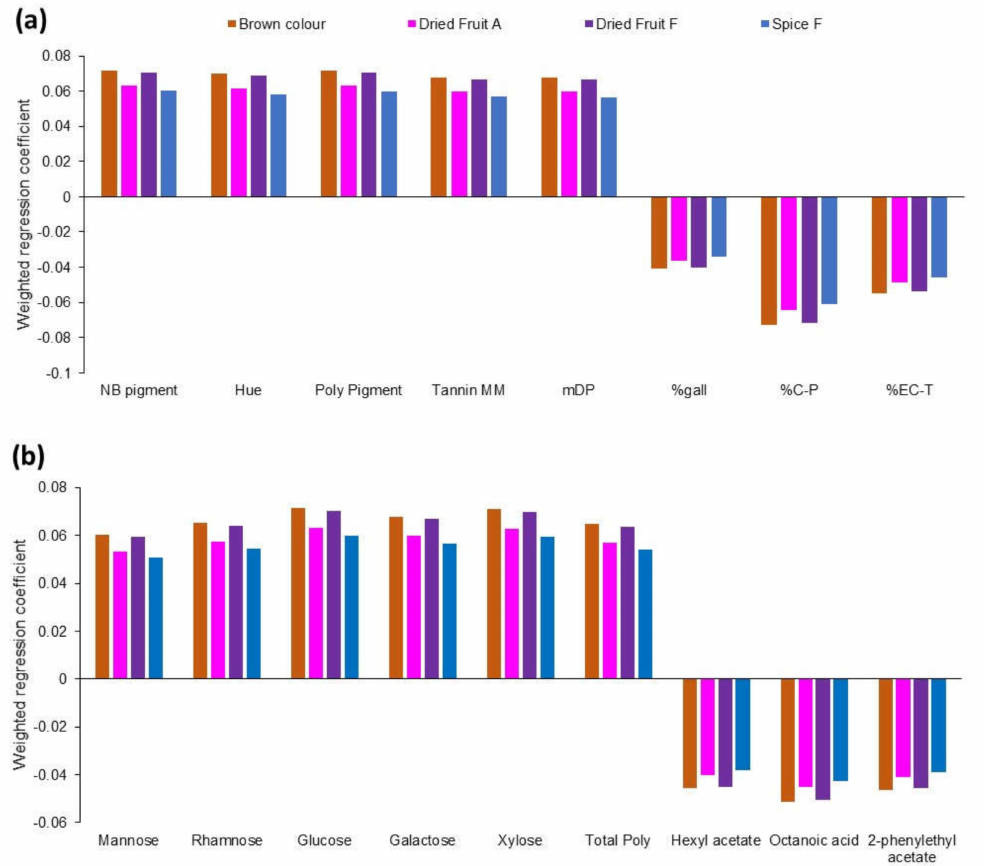
Figure2. Weightedregressioncoe ffi cientsfrompartialleastsquaresregressionanalysisofwell-modelled sensory attributes (A, aroma; F, flavour) from a sub-set of significant variables, ( a ). Phenolic measures (NB pigment, pigments which are non-bleachable, or resistant to bleaching by bisulfite; poly pigment, polymeric pigment; MM, average molecular mass of tannin determined by subunit composition; mDP, mean degree of tannin polymerisation; %gall, degree of tannin galloylation; %C-P, proportion of catechin extension subunits in tannin; %EC-T, proportion of epicatechin terminal subunits in tannin) and ( b ). Polysaccharide-associated monosaccharides (poly, polysaccharide) and fermentation